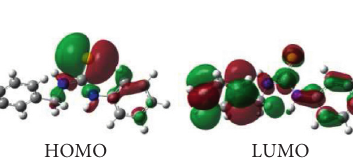
Figure 15: HOMO and LUMO of BPTU. Table 6: Electronic parameters derived for neutral as well as protonated